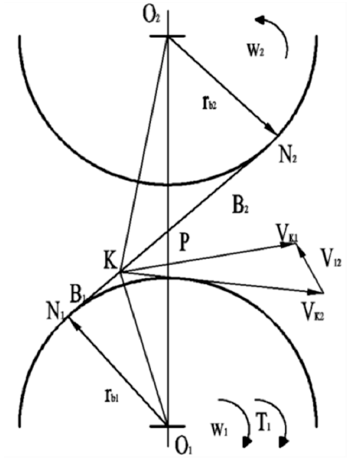
Figure 5. Schematic diagram of external helical gear transmission.